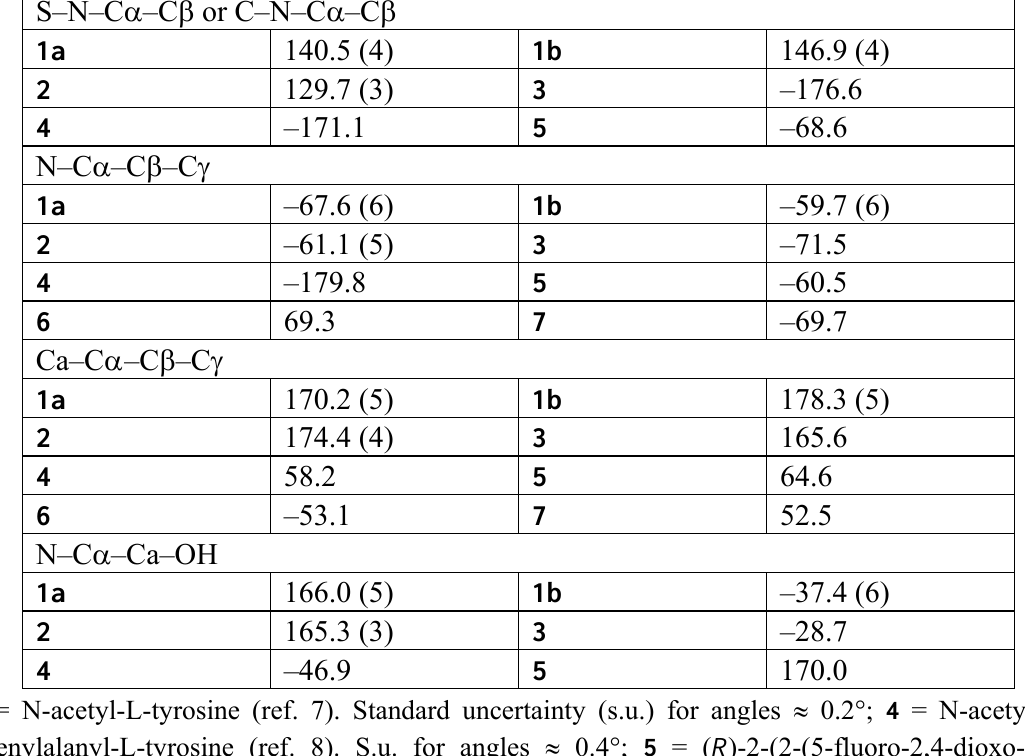
Table 1. Key torsion angles (  ) in 1 , 2 and related